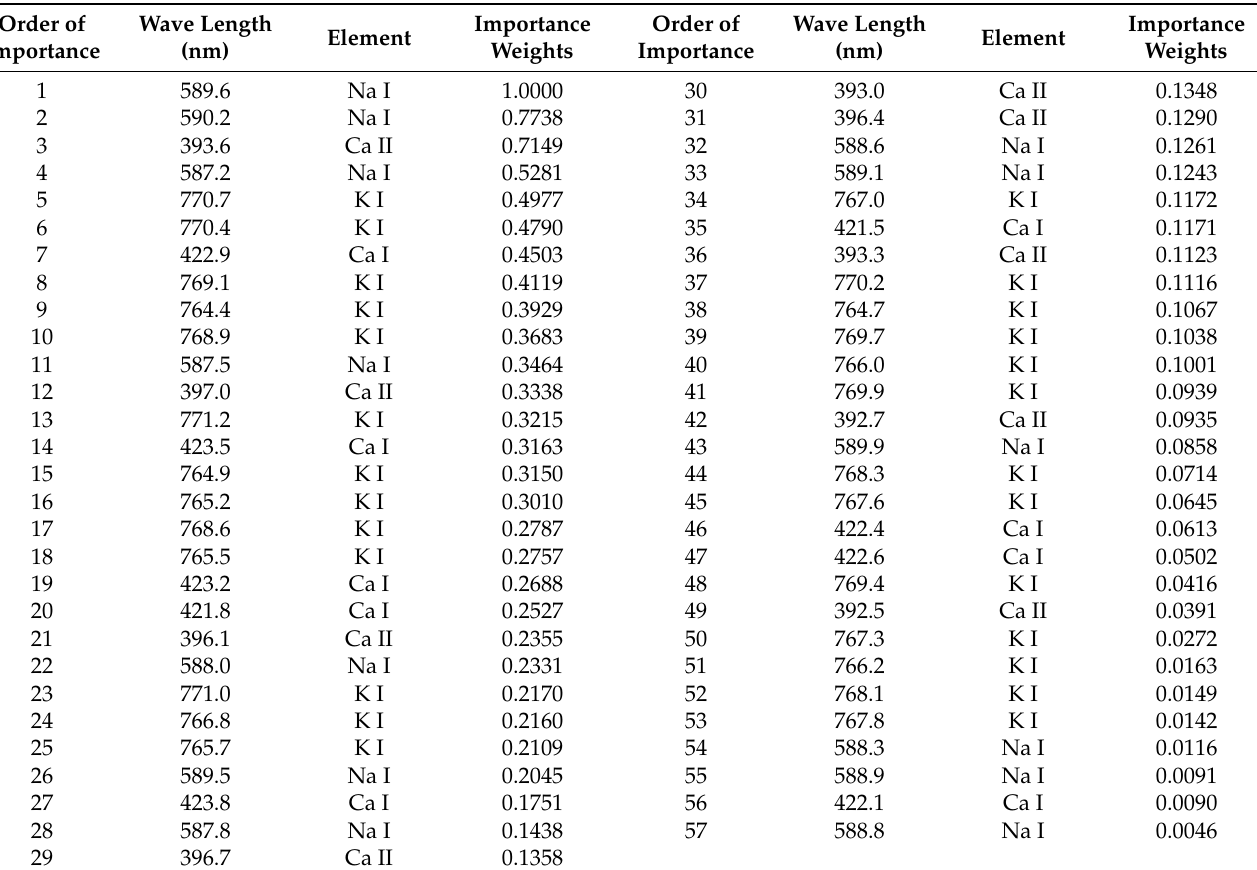
Table 4. Elements and importance weights corresponding to the top 57 wavelengths in impor- tance